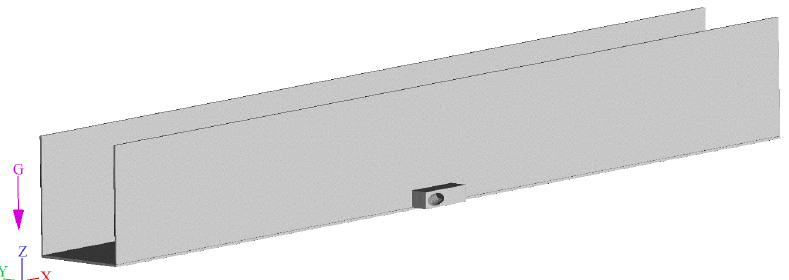
Figure 18. 3D favored view of the channel.